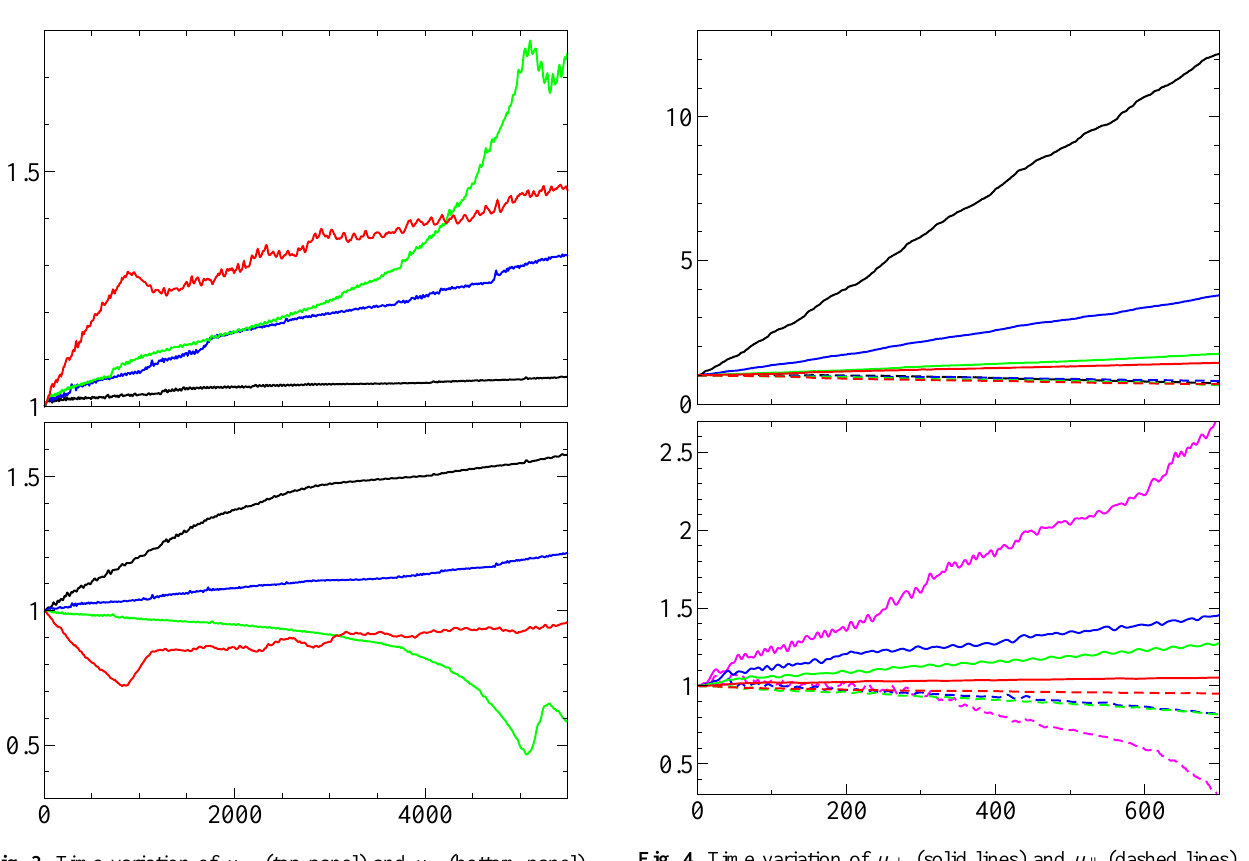
Fig. 3. Time variation of µ ⊥ (top panel) and µ k (bottom panel), for a fixed ratio d i /l f = 0 . 080 and (green series of Fig. 1) β = 0 . 1 (black), β = 0 . 3 (blue), β = 0 . 6 (green), and β = 2 . 4 (red).